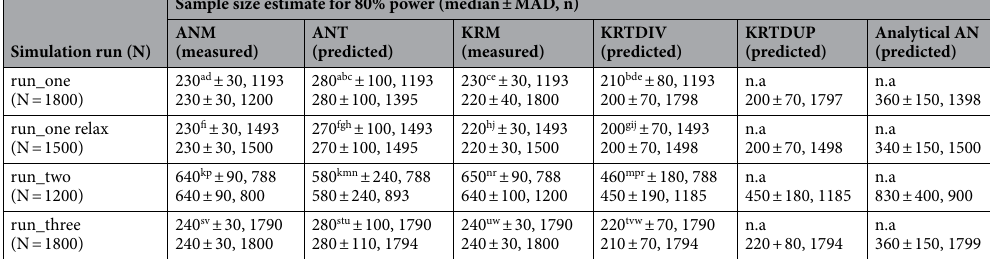
Table 2. Predicted and measured sample sizes for 80% power using Monte-Carlo Kruskal-Wallis tests or Monte Carlo or analytical ANOVA, using samples derived from simulated populations. Results from all Pearson types pooled. ANM ANOVA, measured; ANT Monte-Carlo ANOVA trial, predicted; KRM Kruskal– Wallis, measured; KRTDIV Monte-Carlo Kruskal-Wallis trial, predicted (division algorithm); KRTDUP Monte- Carlo Kruskal-Wallis trial, predicted (duplication algorithm); Analytical AN Analytical ANOVA. See Table 1 for descriptions of simulation runs. N = original number of samples; *The methods for ANT, ANM, KRTDIV, KRTDUP, KRM and Analytical ANOVA are defined in the text. Medians and MAD (= median absolute deviation around the median; R mad(constant = 1 ) to two significant figures: for each run the first rows of numbers are for statistical comparisons between ANT, ANM, KRTDIV or KRM (samples were removed if any of these parameters had missing values; n = number of samples remaining), second rows include values from all samples, regardless of whether one parameter gave a missing value (n = number of non-missing values). Bonferroni-adjusted Brown-Mood median test comparisons with same letter significantly different at p < 0.05, other comparisons not significantly different: abfgprstuv p < 1.32 × 10 −15 ; a Z = 8.23; b Z = 8.88; c Z = 7.78,